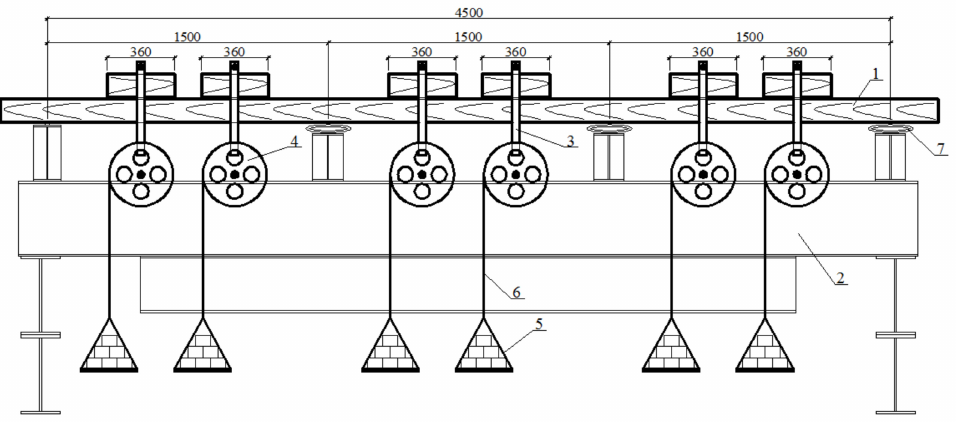
Figure 2. Experimental stand: 1—mounted beam; 2—reactive beam; 3—clamps with wooden lining; 4—transfer shaft-coil; 5—baskets with cargo; 6—cables; 7—dynamometers. Values are expressed in mm.